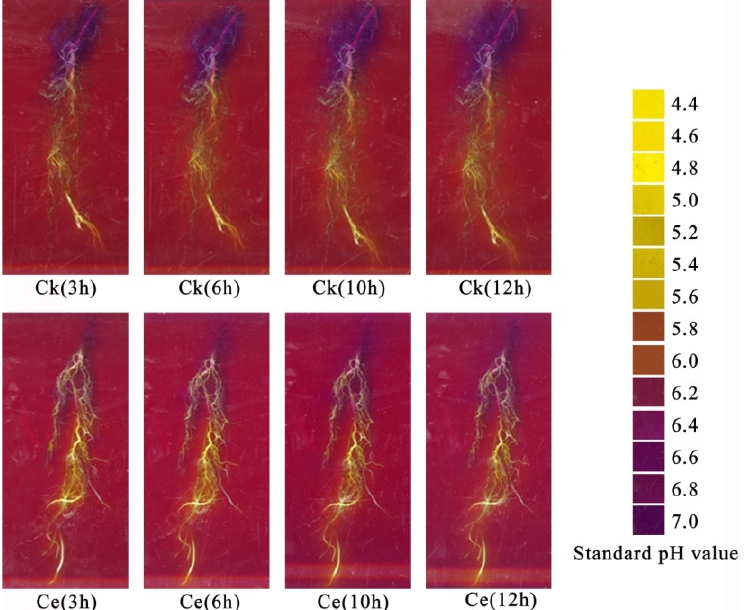
Figure 5. Changes in the rhizosphere pH of maize at different time points. Ce, Claroideoglomus etunicatum ; Ck, control.